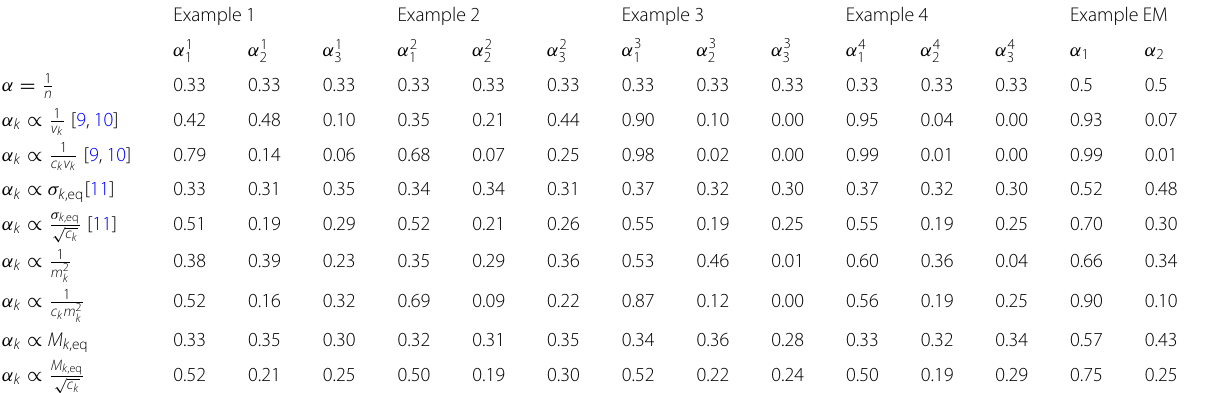
Table 6 α j : α i values for the j -th 1D example and for the environment map example i Example 1